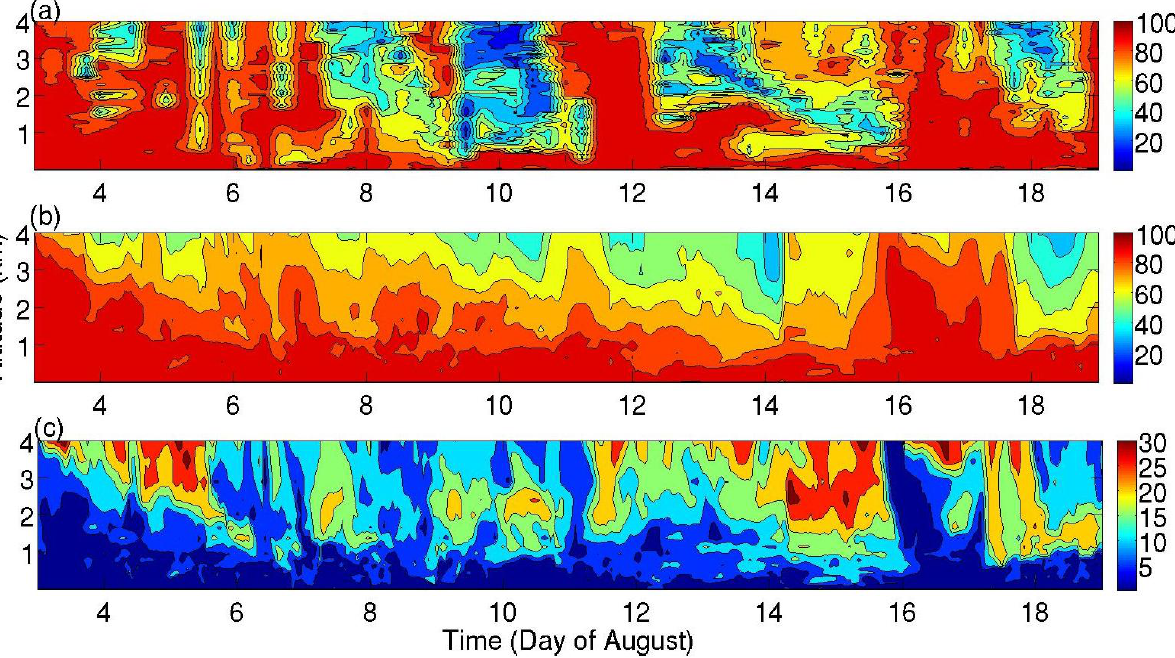
Figure 4. Time-height cross-sections of atmospheric relative humidity (%) showing ( a ) observations, the modeled ( b ) ensemble average and ( c ) model ensemble standard deviation. Model ensemble statistics are based on hourly model output while observations were nominally taken